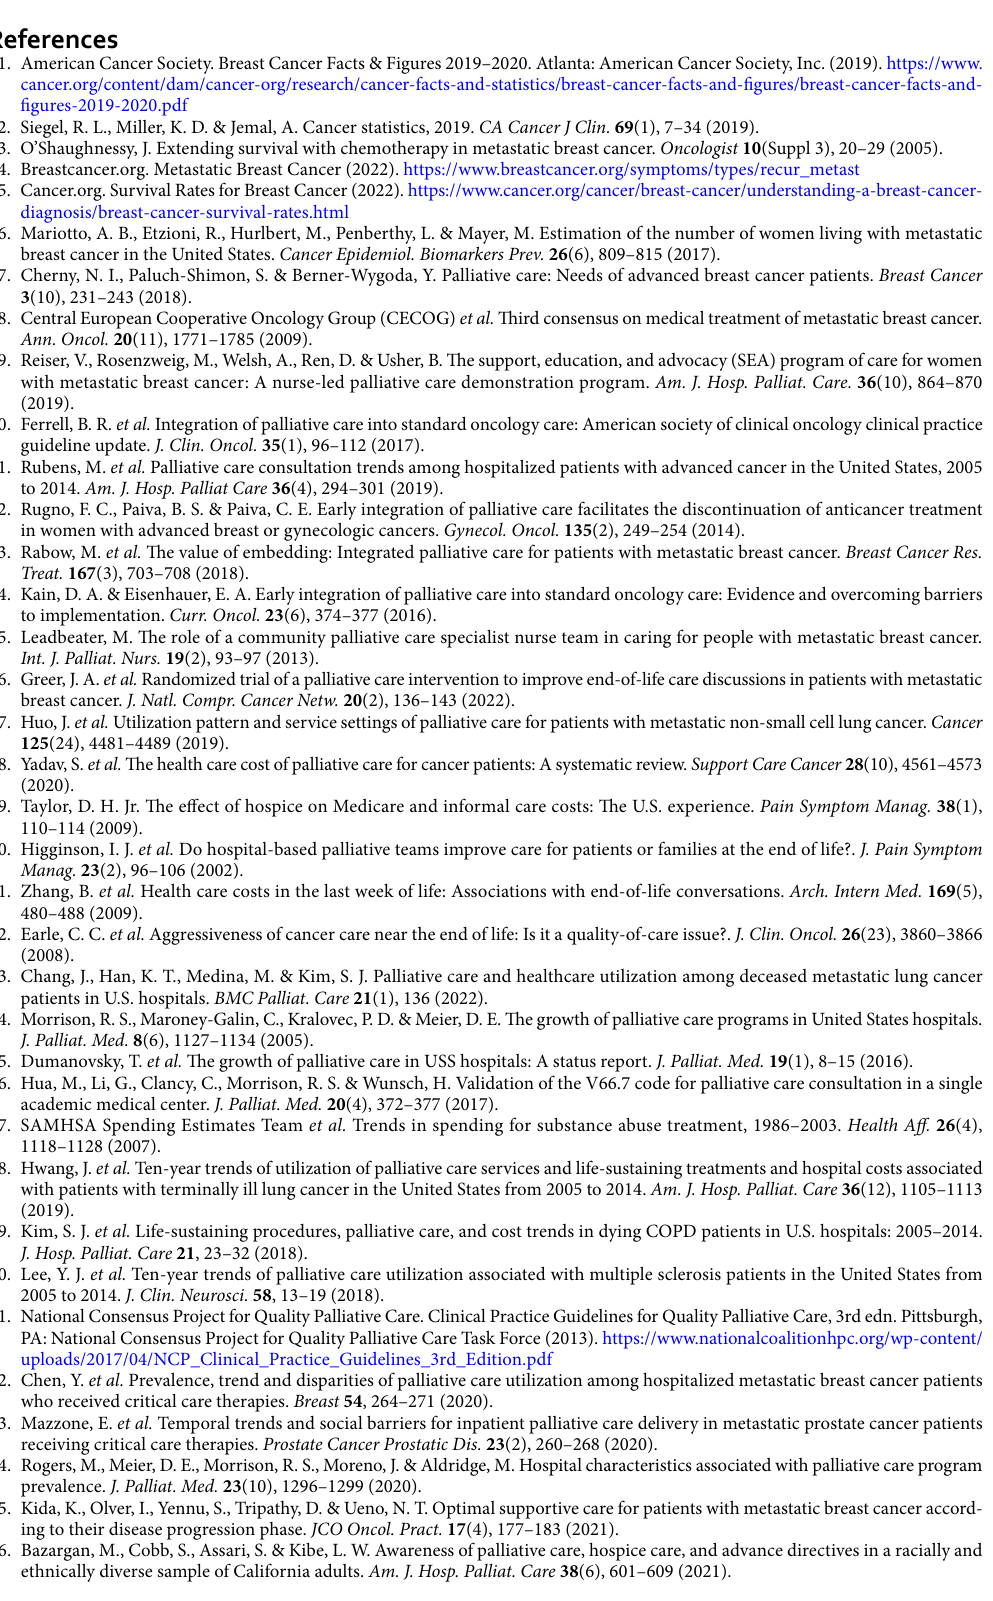
figur es- 2019- 2020. pdf 2. Siegel, R. L., Miller, K. D. & Jemal, A. Cancer statistics, 2019. CA Cancer J Clin. 69 (1), 7–34